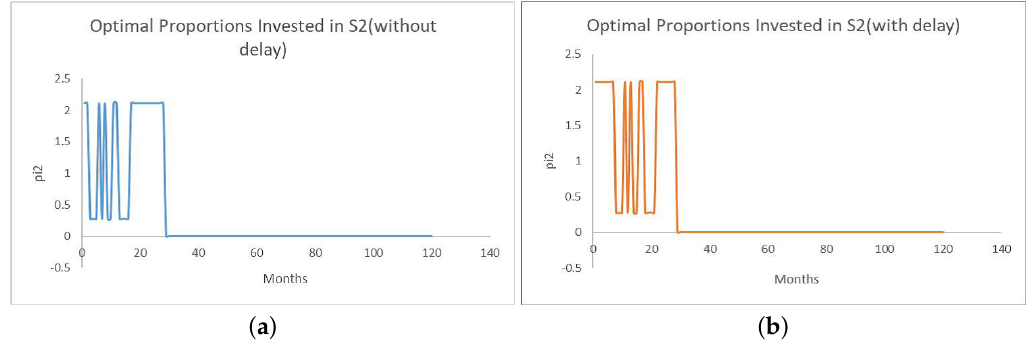
Figure 4. Simulated optimal proportions invested in S 2 for the cases without and with delay. Panel ( a ) and ( b ) for the optimal proportions invested in the defaultable security with and without time